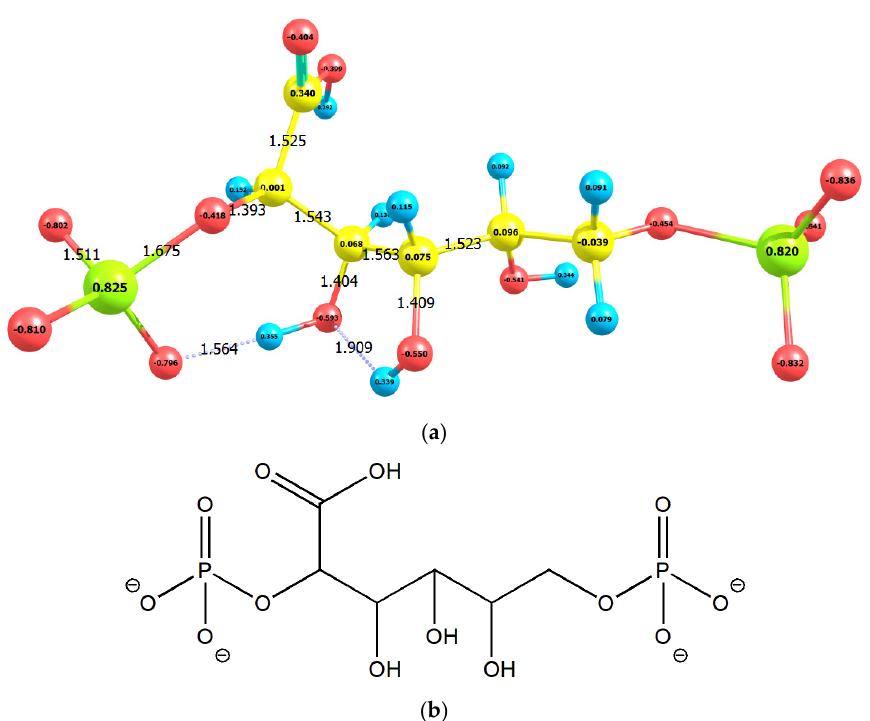
Figure A8. ( a ) The calculated geometric and electronic structure of 2,6-bisphosphate gluconic acid (BPGA); Q = − 4, M = 1, E 0 = − 51,603.38 eV, G 0 = − 51,599.04 eV. Hessian has negative frequencies: − 33.21 (cm − 1 ). ( b ) The scheme of 1-carboxy-2,3,4-trihydroxypentane-1,5-diyl diphosphate.